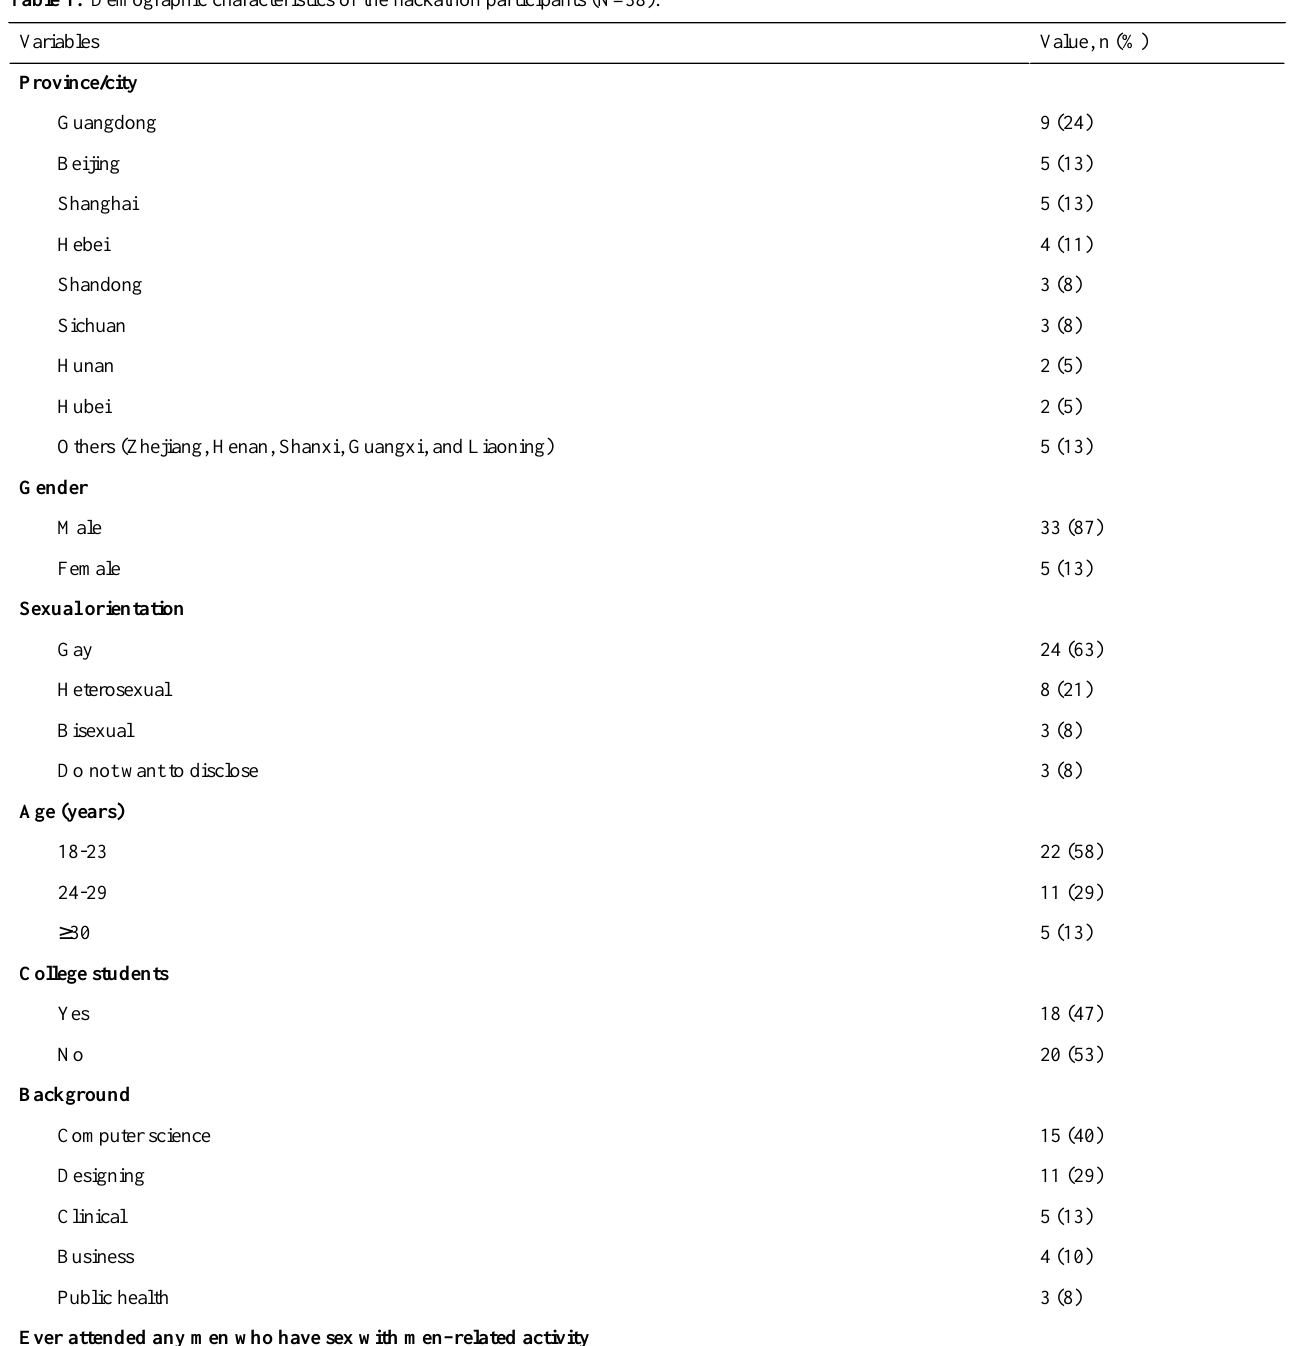
Table 1. Demographic characteristics of the hackathon participants